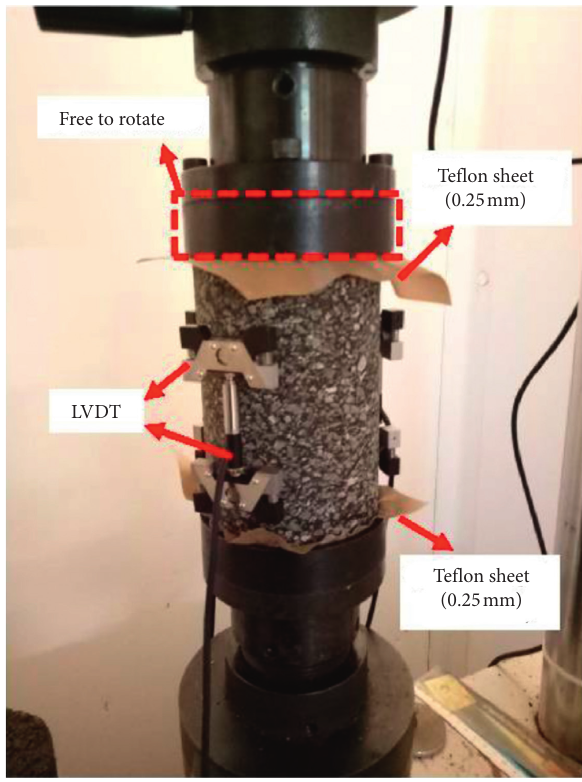
Figure 6: Dynamic modulus test system. Table 3: Testing conditions of the dynamic mechanical test. Test